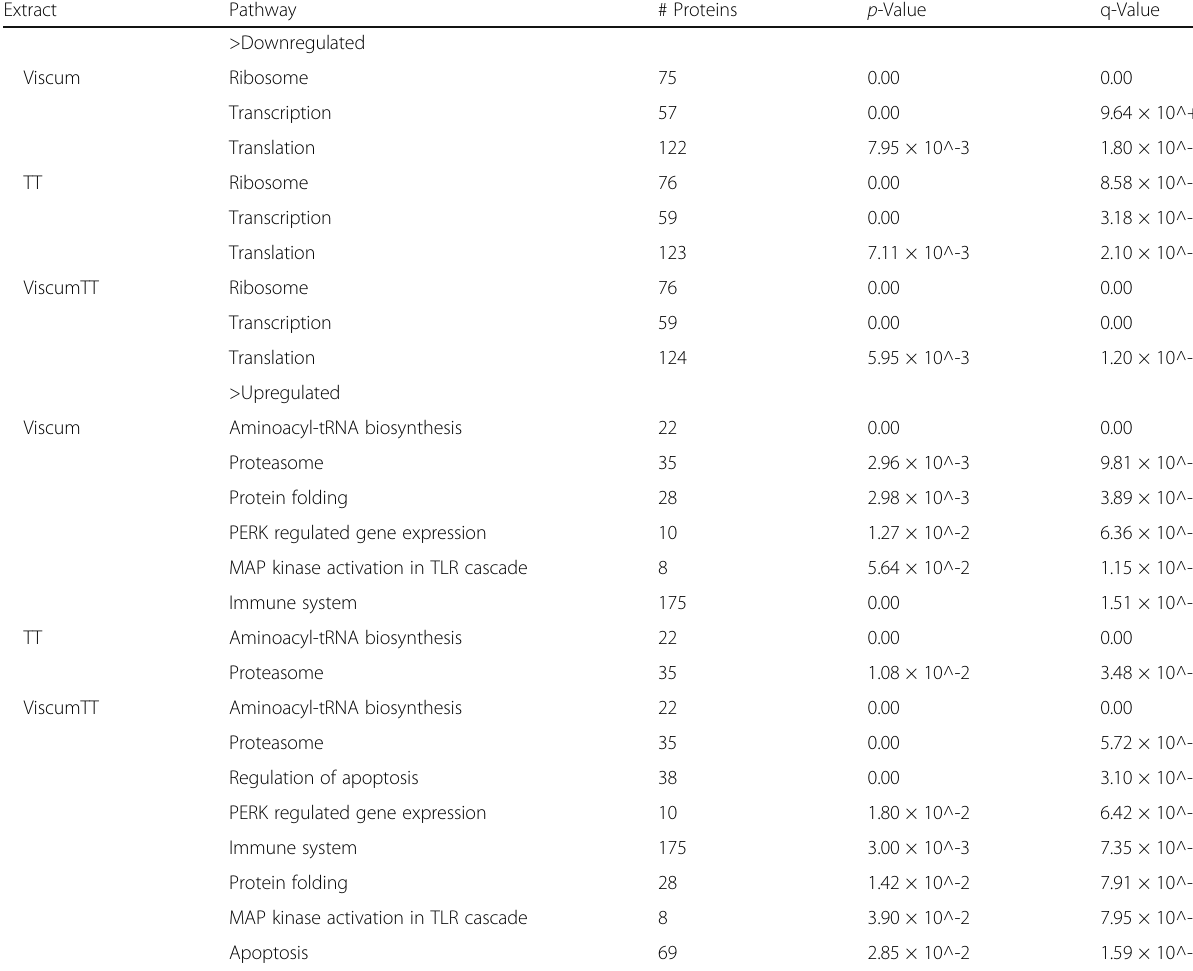
Table 2 Significantly regulated KEGG and Reactome pathways in TC-71 cells treated 24 h with viscumTT, viscum or TT versus untreated control